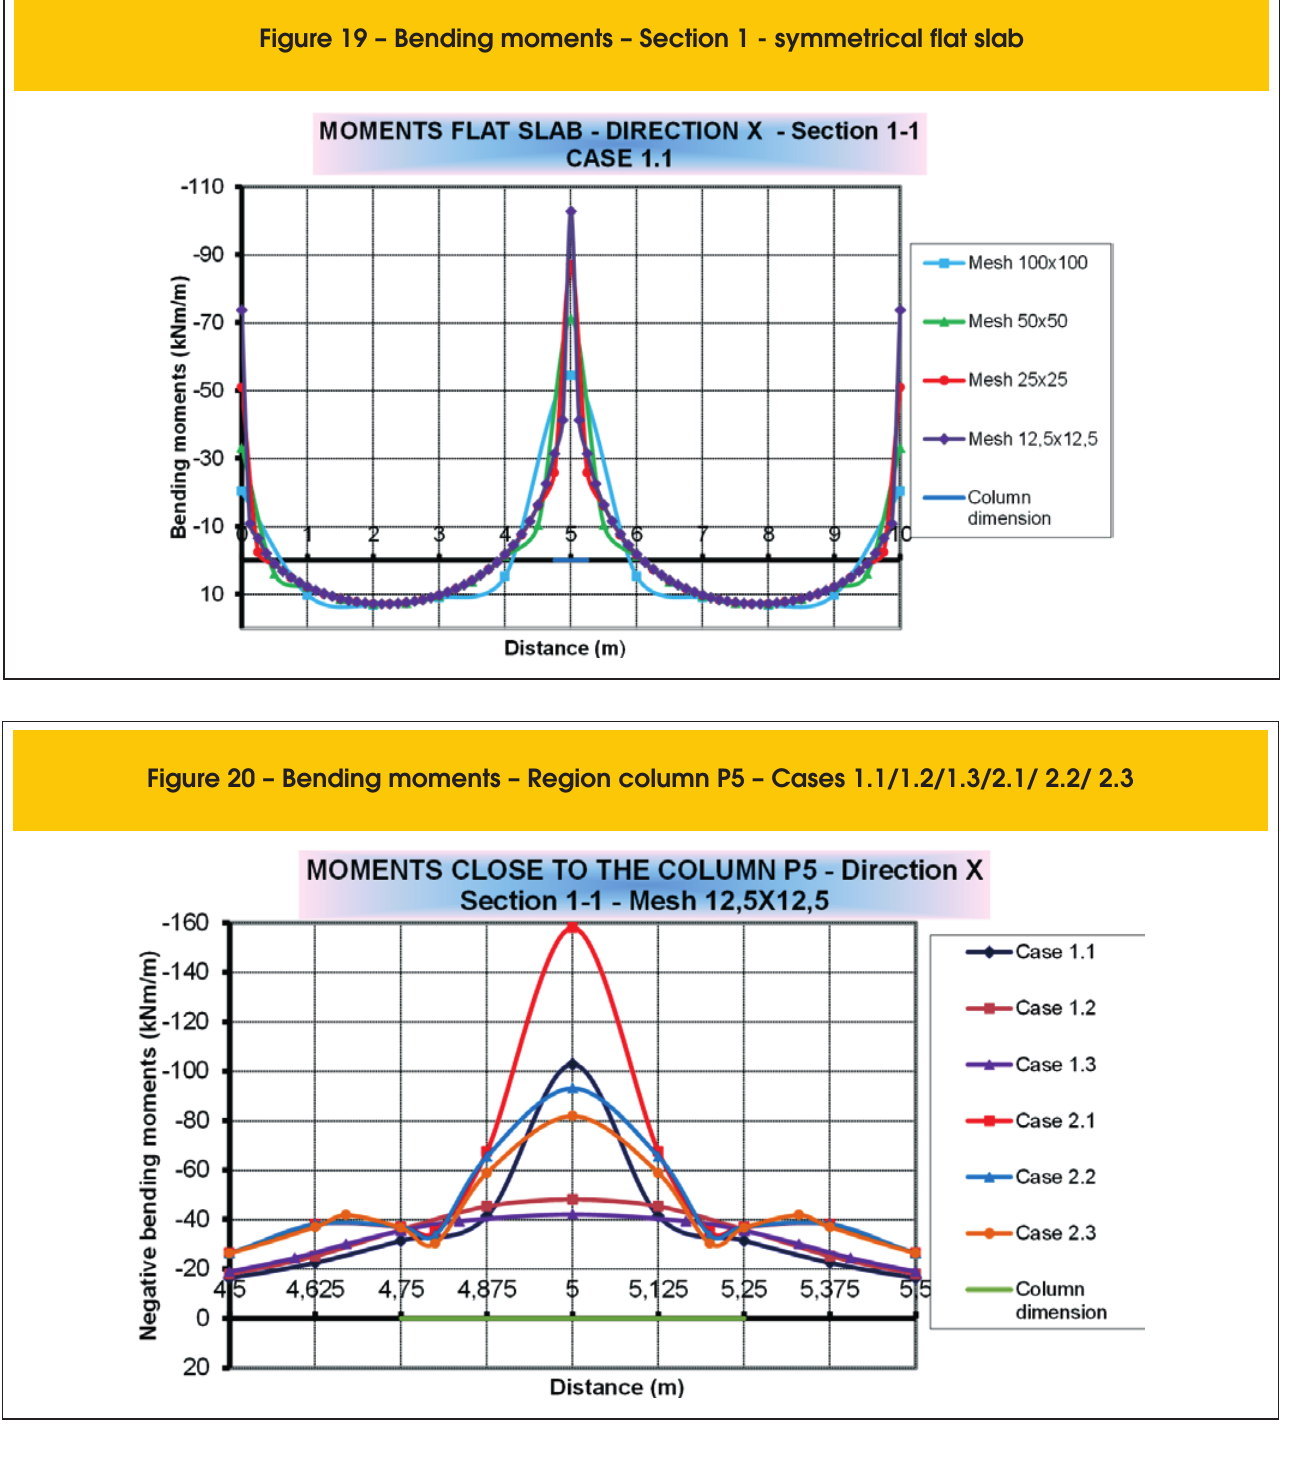
Figure 29 and Figure 30 show the bending moments at the left and right sides of the column P5, respectively. Except with mesh of 25x25cm, the moments in both faces of the column P5 are about the same for the Cases 3.2 and 3.3, 4.1 and 4.2. The Case 4.3 showed results noticeably greater than the Cases cited